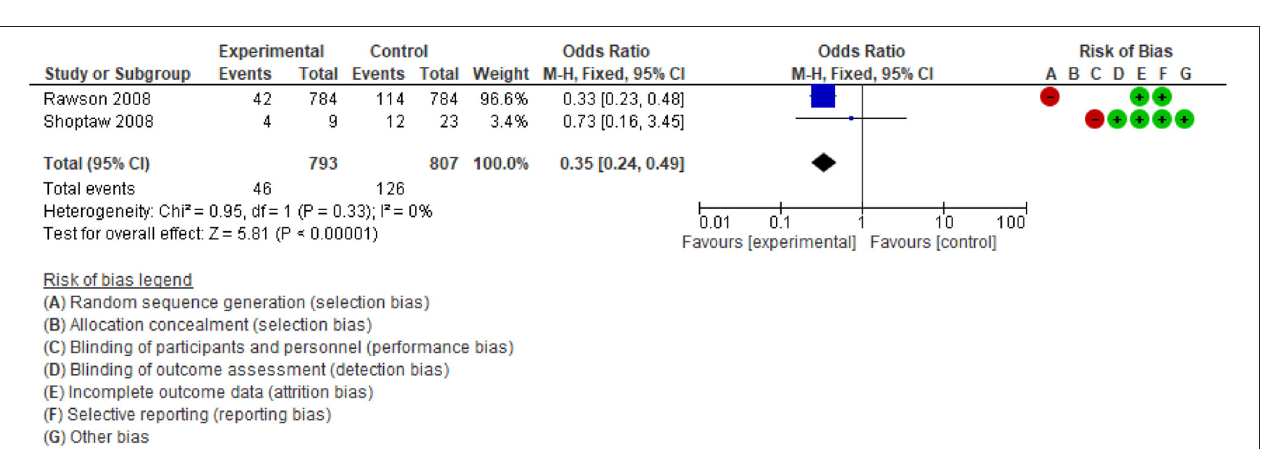
FIGURE 6 | Comparison Beck Depression Inventory Score.